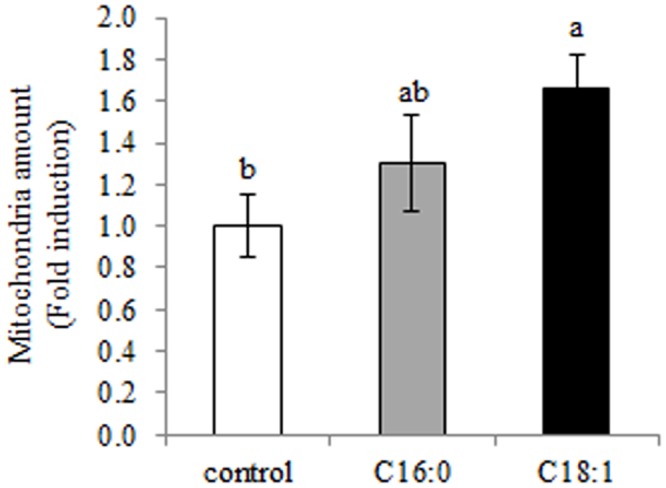
Specific free fatty acids (FFAs) in culture medium alter mitochondrial quantity in mammary epithelial cells.Mammary epithelial cells were treated with 100 μM FFA (palmitic or oleic acid) or with FFA-free medium (control) for 24 h, and mitochondria were stained with Mitotracker deep red FM. Mitochondrial amount was determined by quantification of the fluorescence intensity of Mitotracker deep red staining and presented as fold change compared to the control. Data are presented as mean ± SEM. Different letters indicate significant differences between treatment groups (P < 0.05).